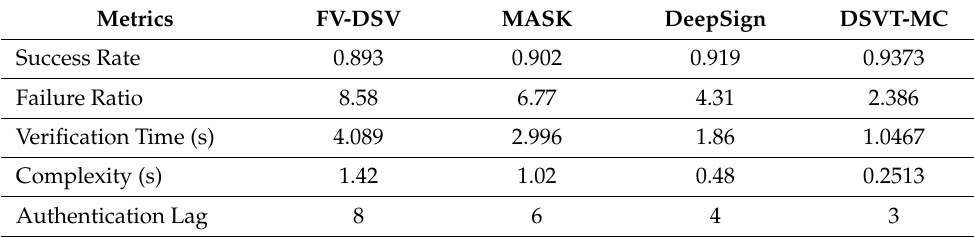
Table 3. Comparative analysis summary